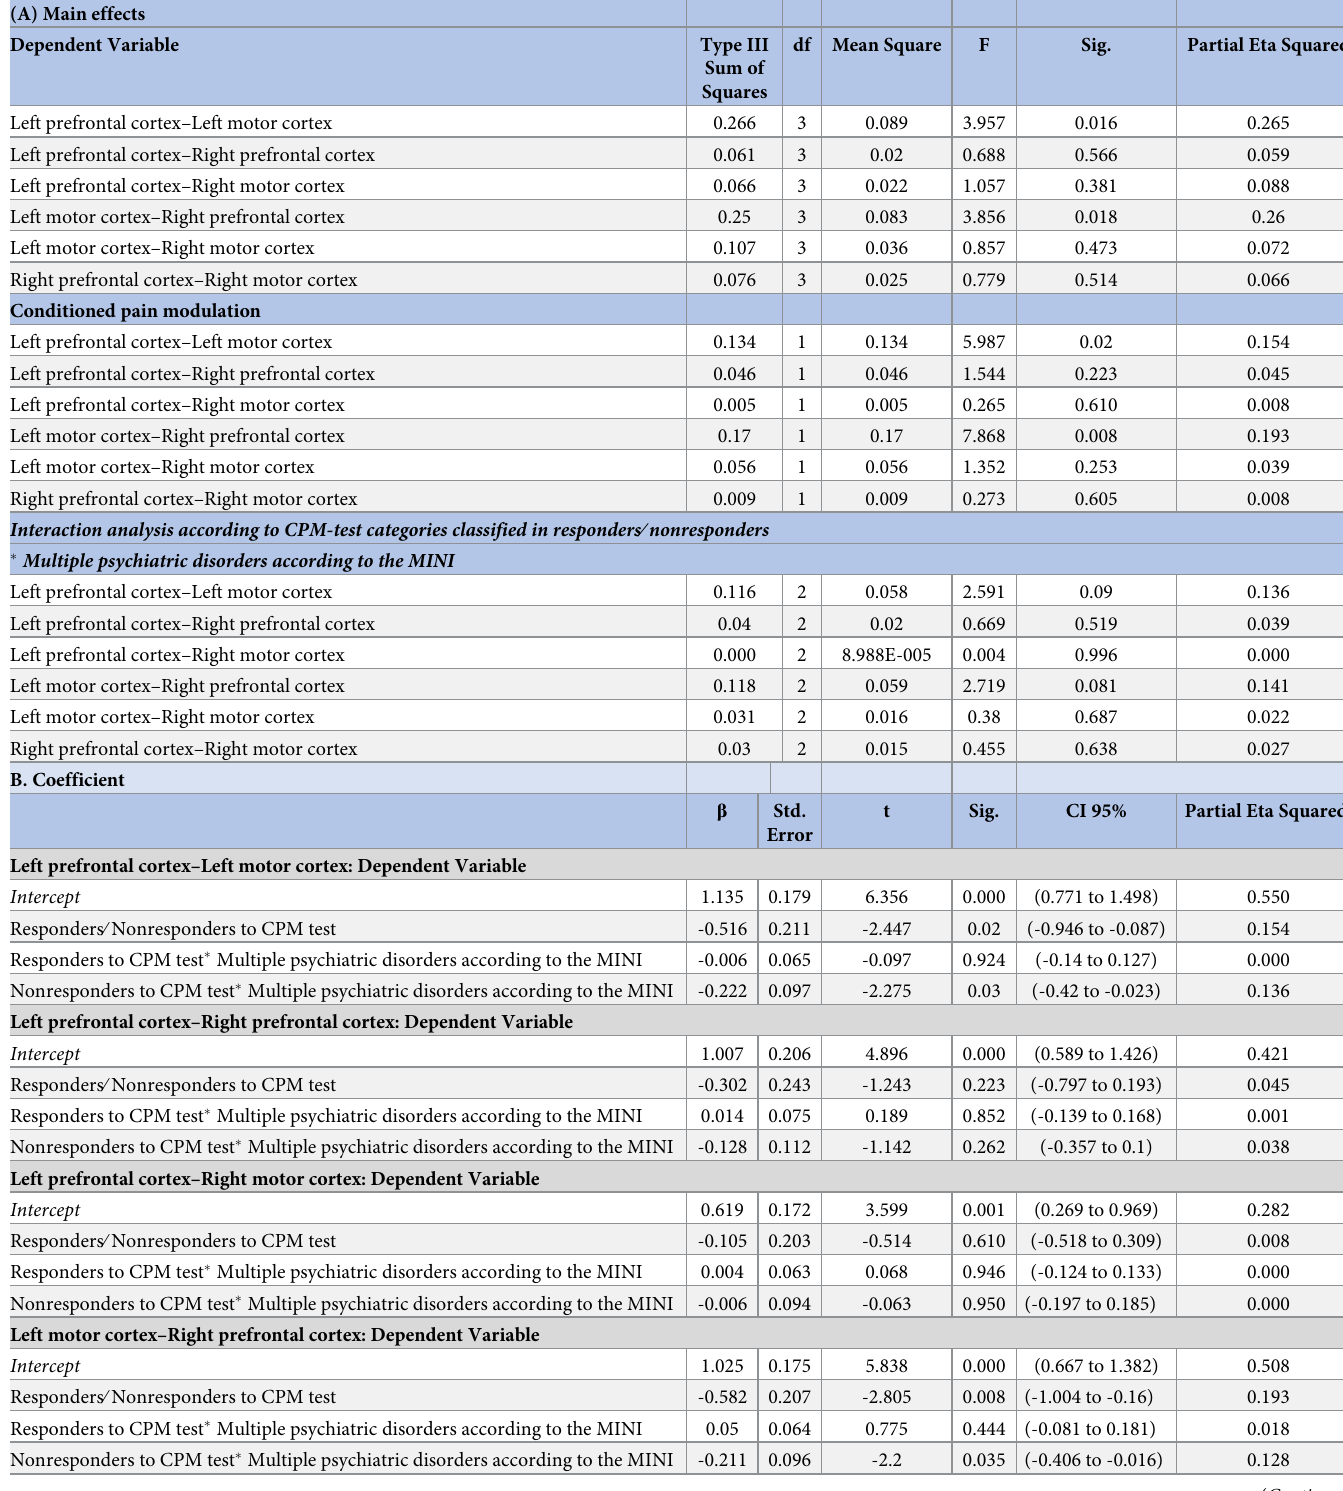
Table 4. MANCOVA analysis of the relationship between the FC according to the interaction analysis between the spectrum of responders or nonresponders on the CPM-test by psychiatric disorders according to the MINI (n =